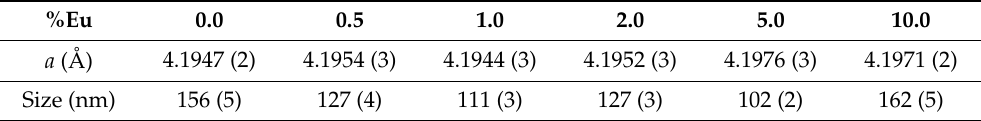
Table 1. Lattice constants and crystallite sizes of the BZOE obtained from Rietveld refinement of the XRD data shown in Figure